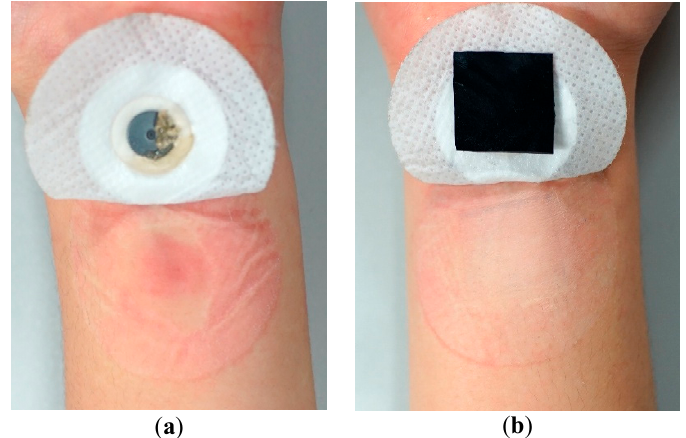
Figure 10. Skin reaction comparison of wearing an Ag/AgCl electrode ( a ) and a MWCNT/PDMS sheet ( b ) for 7 days.